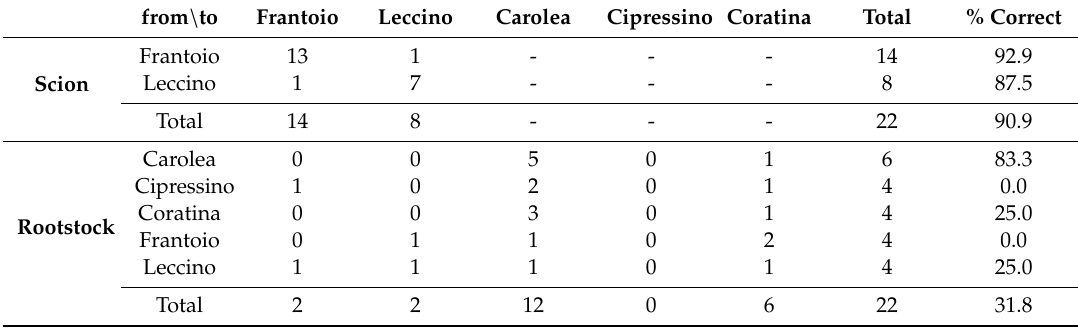
Table 3. Classification matrix for the validation sample (whole vegetation index dataset for 22 cases), with cases in rows and classification values in